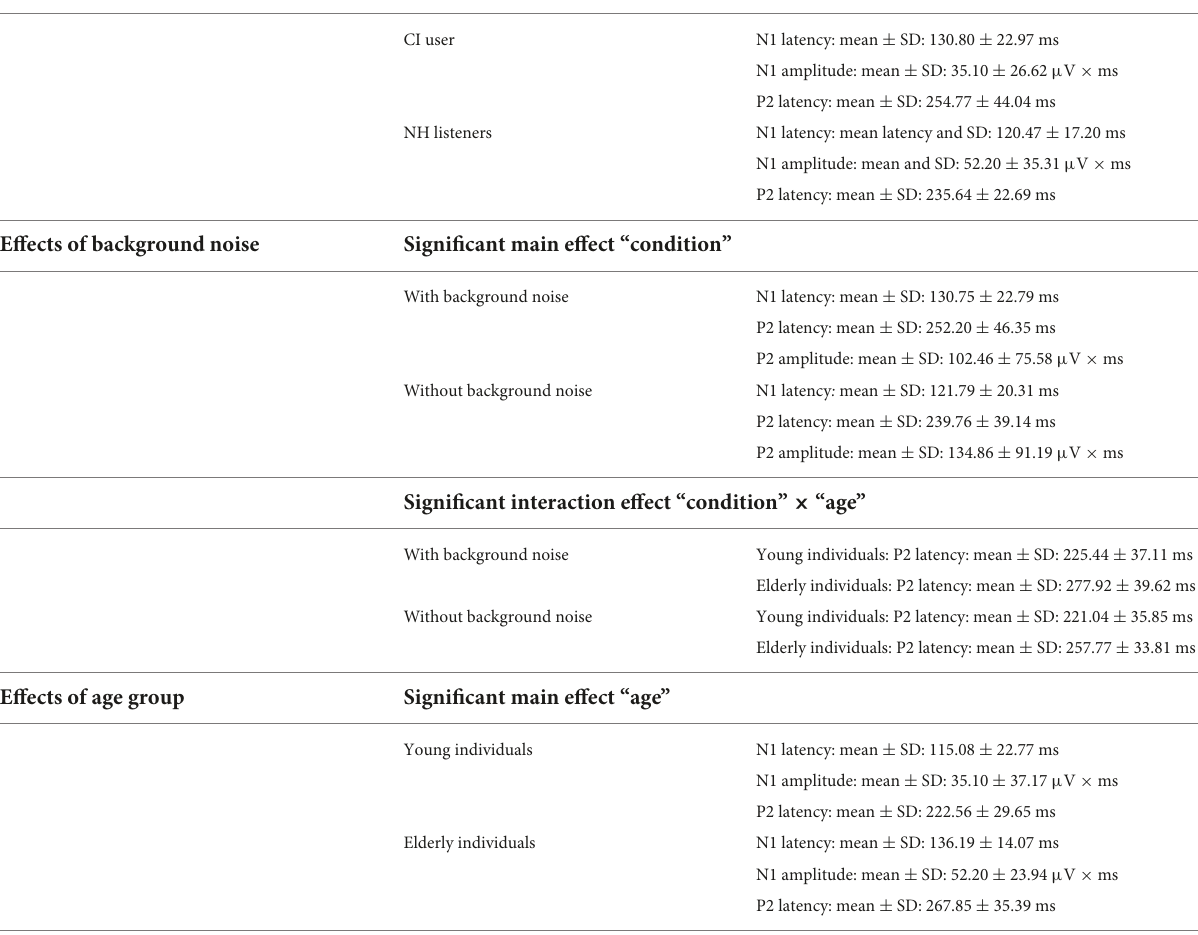
TABLE 3 Mean and SD of N1, P2 latencies and amplitudes (ERP results: Sensory-driven processes). Effects of the hearing